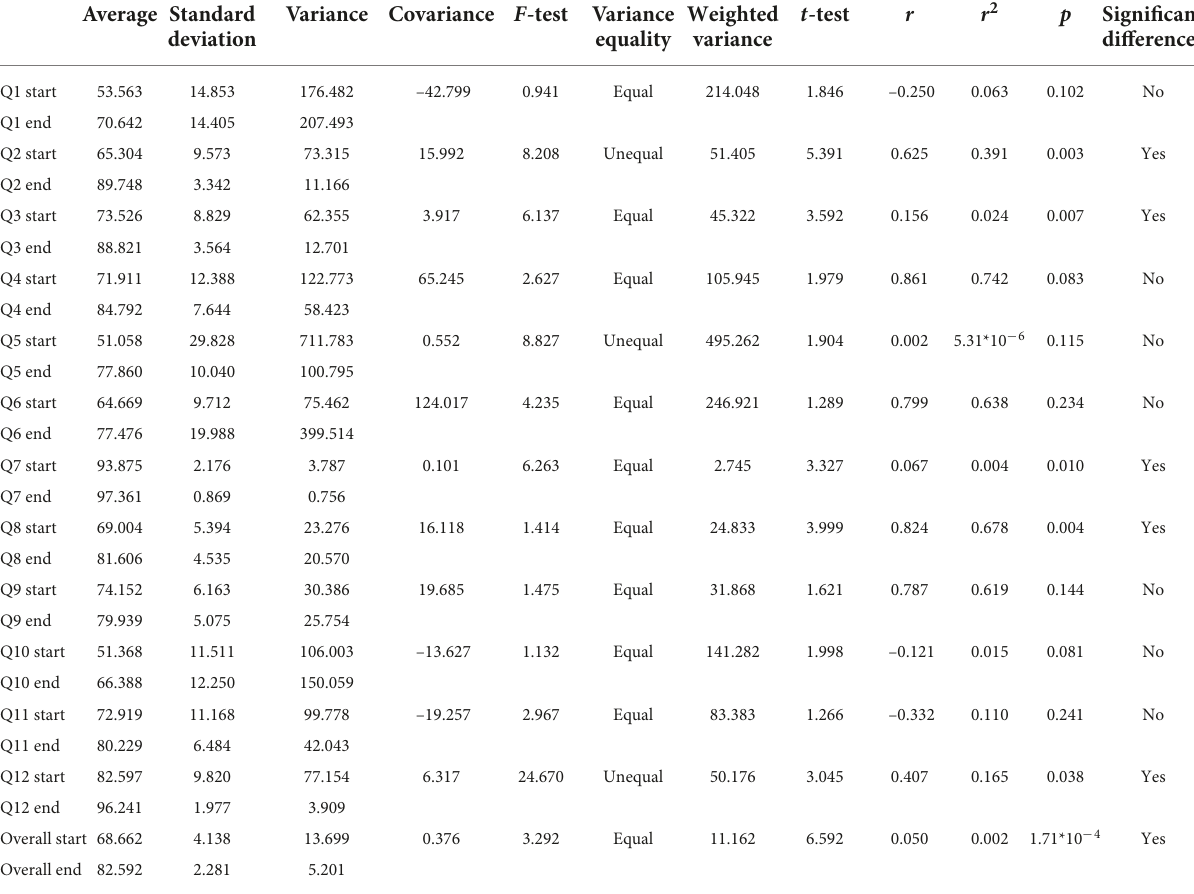
TABLE 1 Statistical parameters at a 95% confidence interval of the comparison between results obtained at the start and at the end of the SWICEU project. Average Standard Variance Covariance F -test Variance deviation